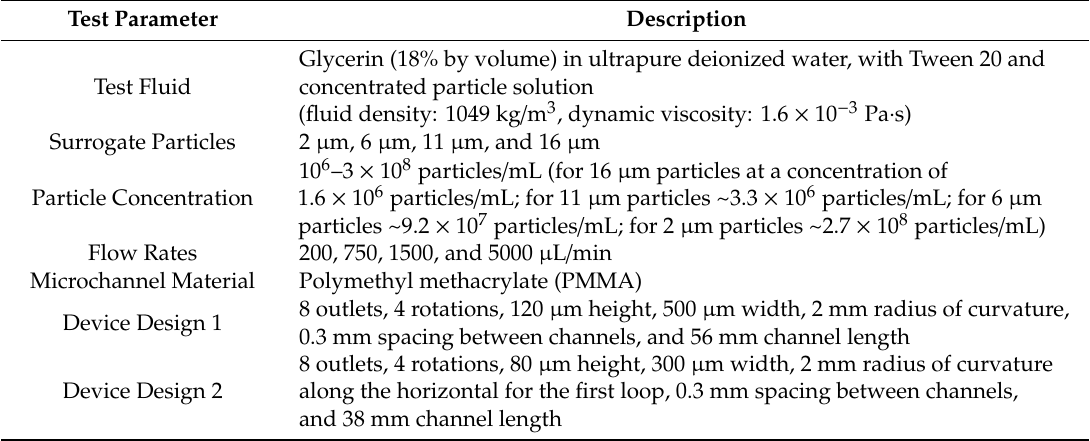
Table 2. Test parameters investigated in this